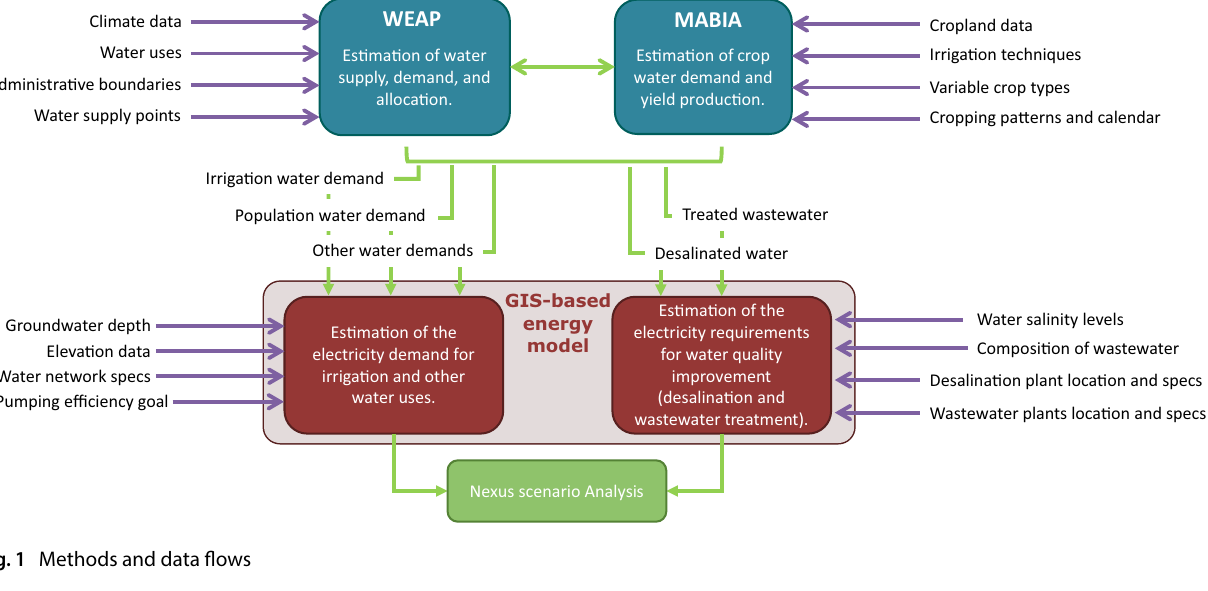
Fig. 1 Methods and data